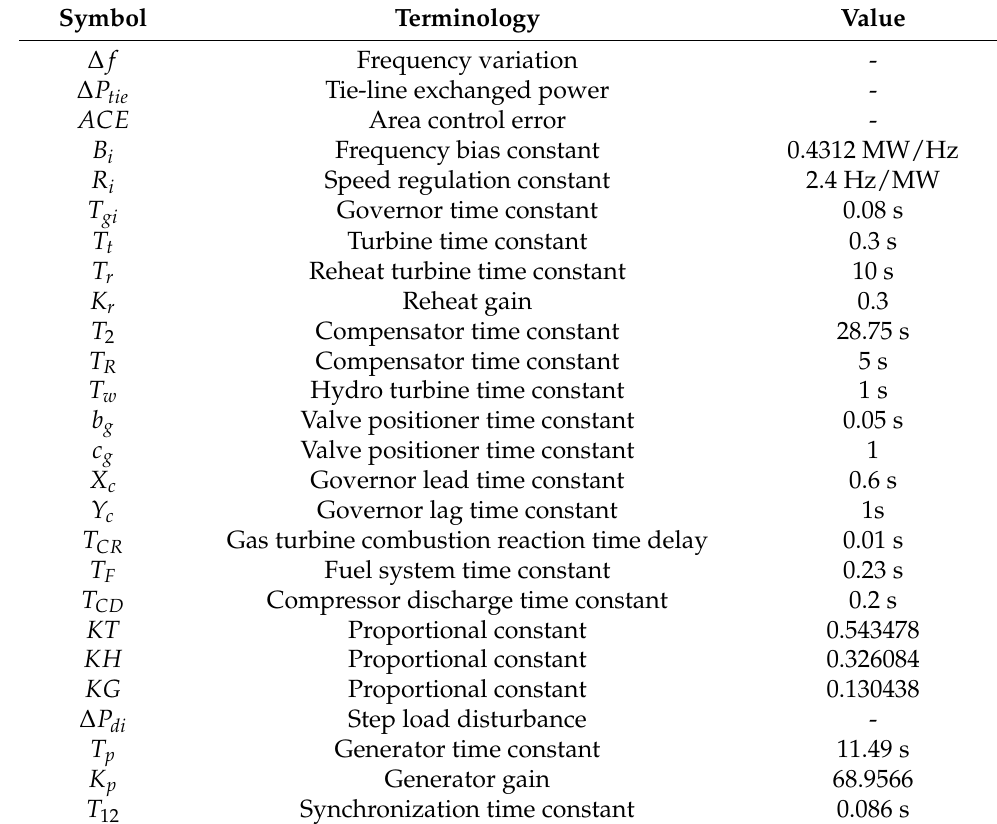
Table 1. Symbol definitions and